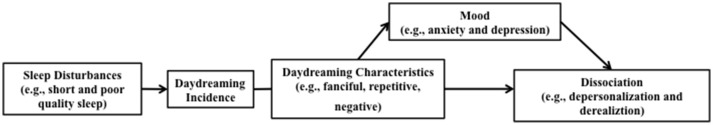
A proposed model of how daydreaming is related to dissociation.